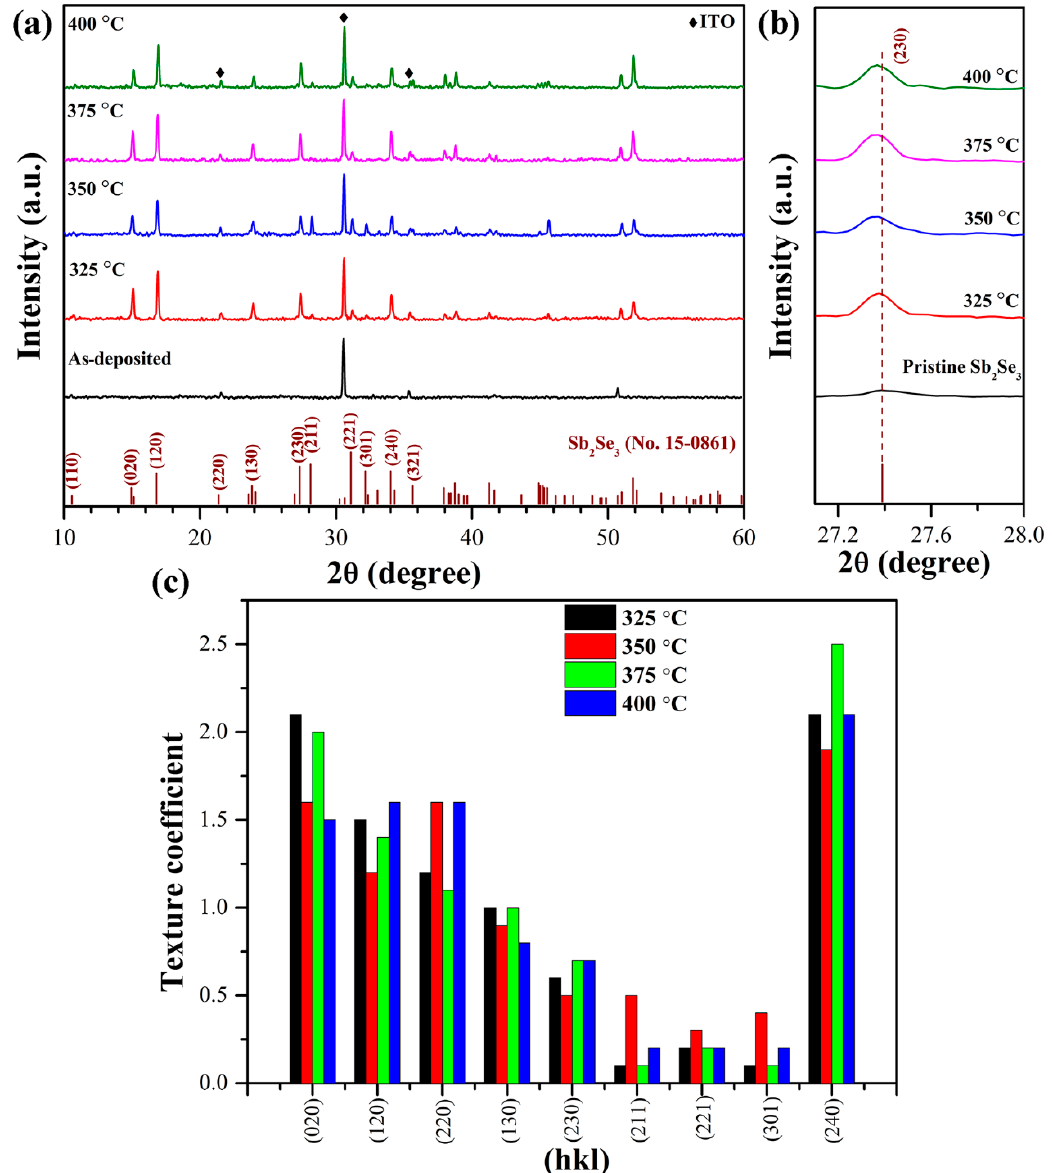
Figure 2. ( a ) XRD patterns of Te-Sb 2 Se 3 thin films on indium tin oxide (ITO) with di ff erent annealing temperatures. ( b ) Shift of (230) peak of crystalline Te-Sb 2 Se 3 thin films as shown in XRD patterns compared with pristine Sb 2 Se 3 . ( c ) Texture coe ffi cients of di ff raction peaks based on XRD